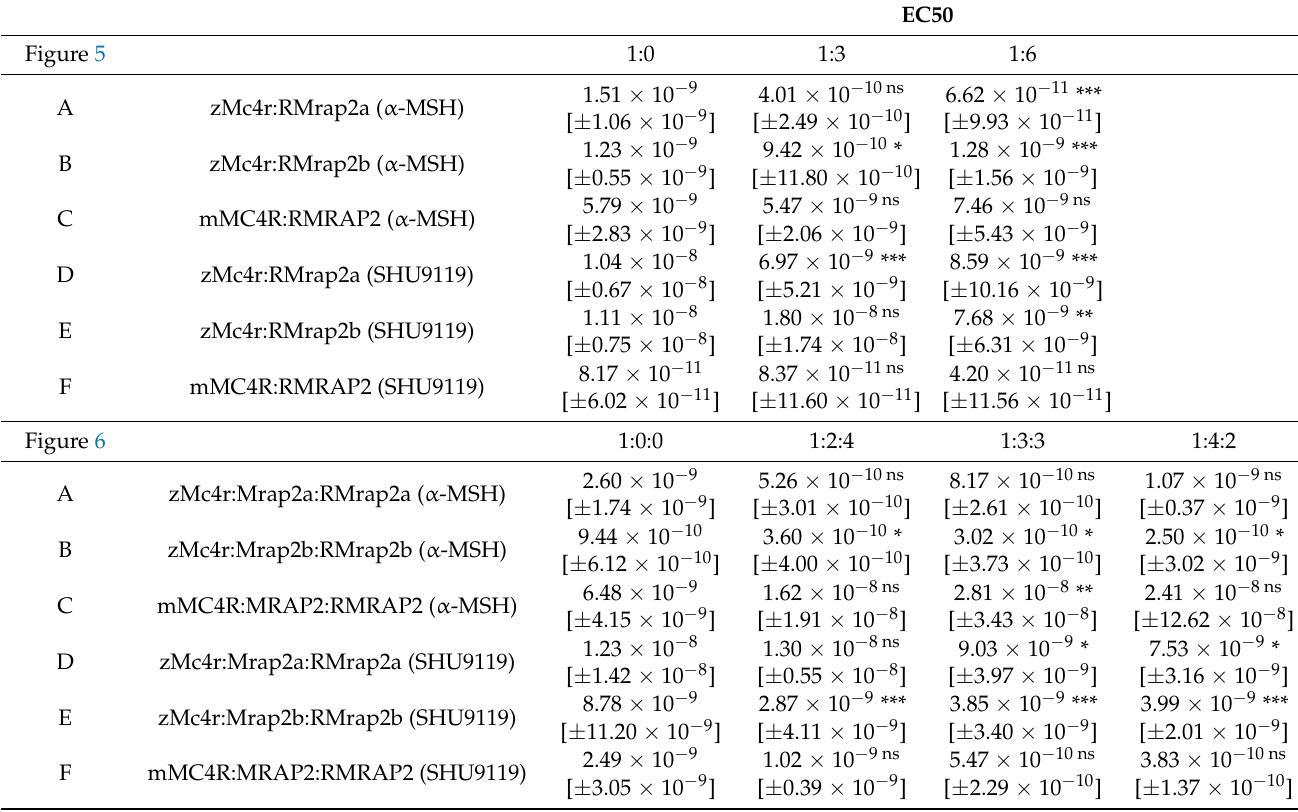
Table 1. Pharmacological summary for logEC50 of dose–response curves in Figures 5 and 6.